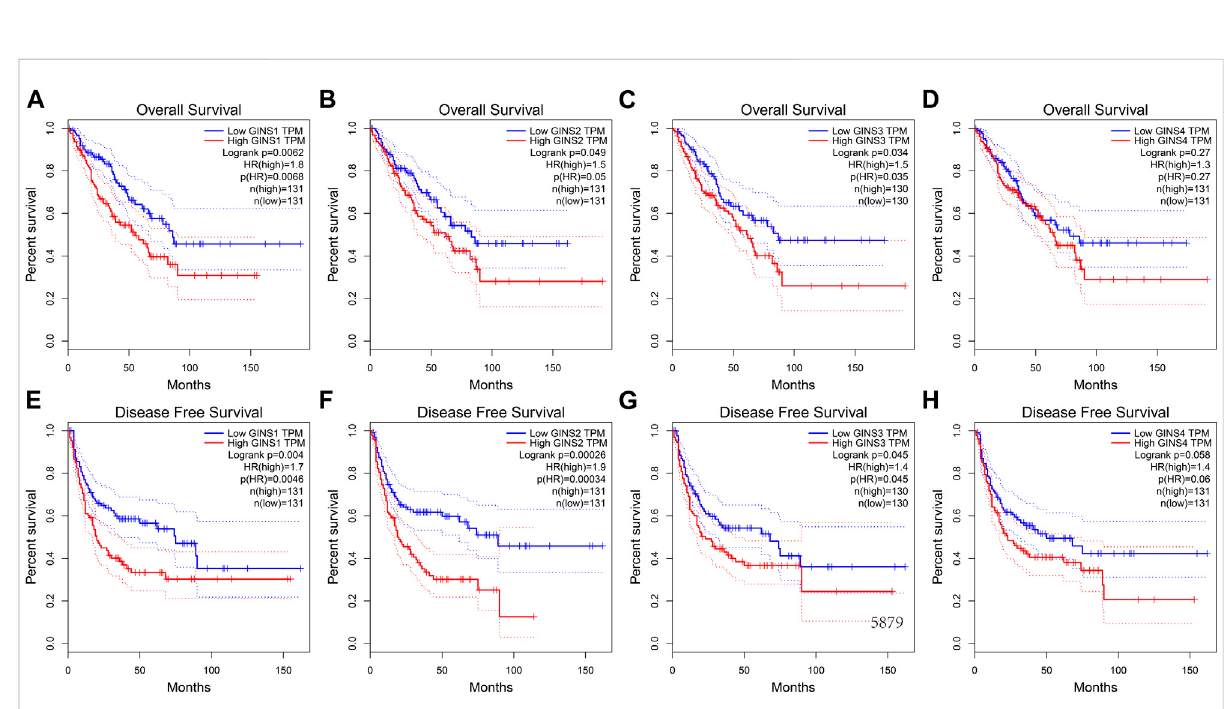
FIGURE 6 The prognostic value of GINS subunits in sarcoma patients (GEPIA). OS curves of GINS1/2/3/4 in SARC (A – D) . DFS curves of GINS1/2/3/4 in SARC (E – H) .